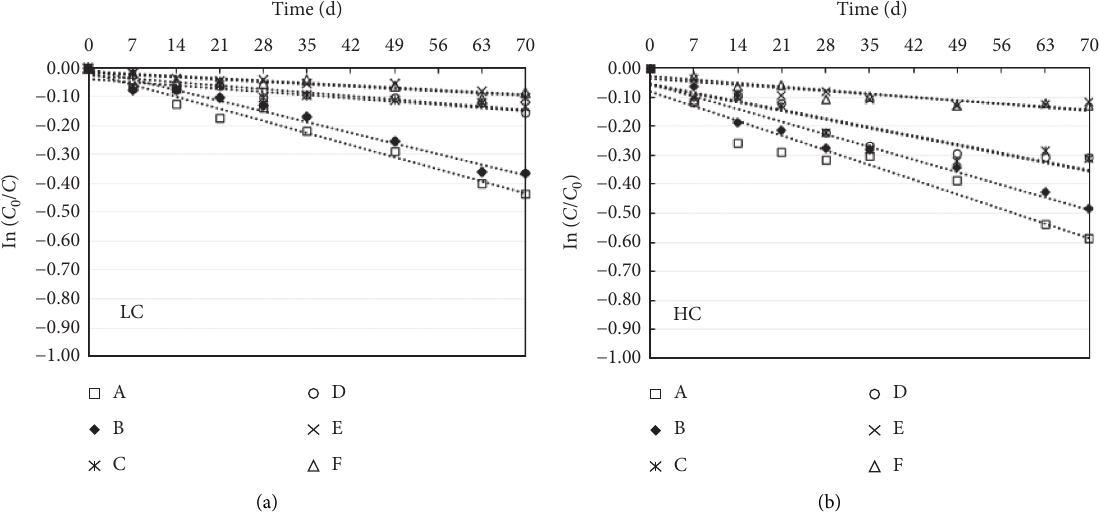
Figure 3: First-order plots of vitamin D 3 degradation during storage. A: samples stored in transparent bottles at room temperature with filling level of 50%; B: samples stored in transparent bottles at room temperature with filling level of 100%; C: samples stored in dark-brown bottles at room temperature with filling level of 50%; D: samples stored in dark-brown bottles at room temperature with filling level of 100%; E: samples stored in dark-brown bottles at 4 ° C with filling level of 50%; F: samples stored in dark-brown bottles at 4 ° C with filling level of 100%. Table 4: Effect of storage conditions on the activation energy ( E a ), reaction rate constant ( k ), Q 10 , and half-life of vitamin D 3 in LC and HC. Oil Model